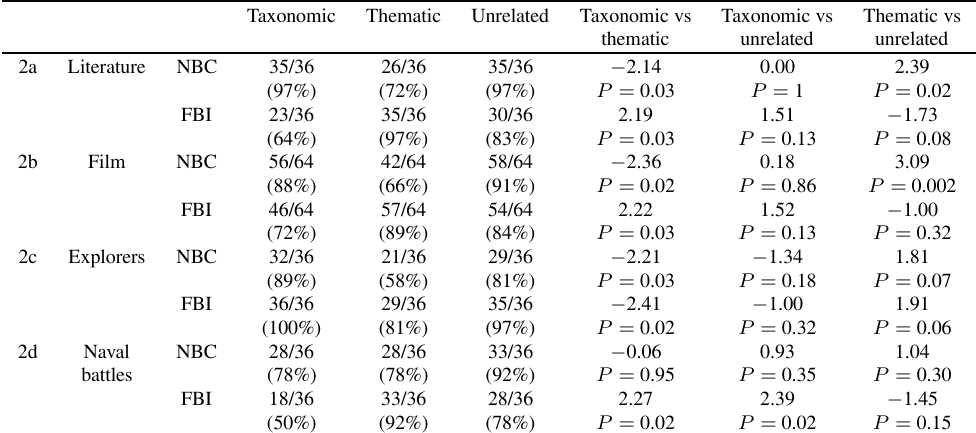
Table 3 Number and percentage correct responses in each taxonomic, thematic and unrelated condition in Experiment